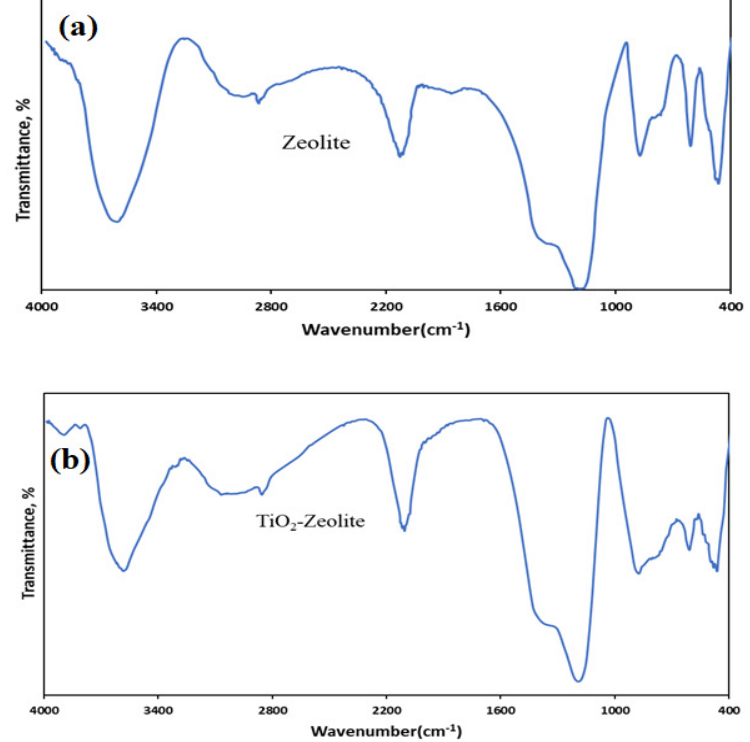
Fig.1. FTIR spectra of zeolite(a), and TiO